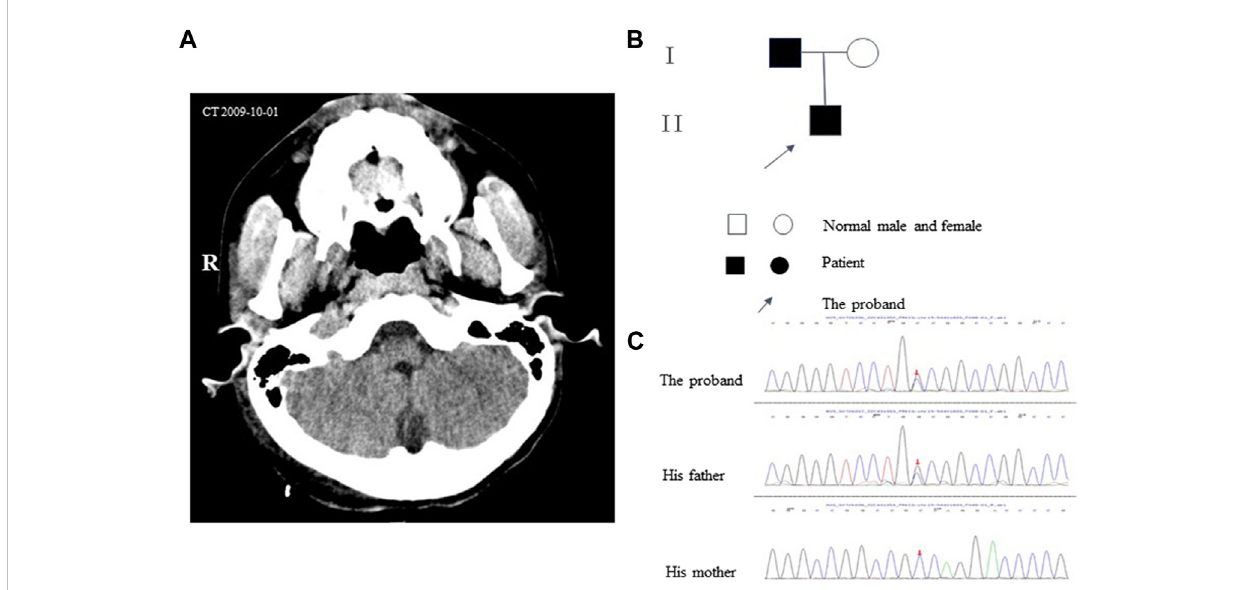
FIGURE 1 |(A) Axial CTimagesshowing thecerebellum. (B) Pedigreesofthe family. (C) The result of genesequencing ofthe PRKCG gene. The arrowindicates the c.1232 (exon11)G > C.